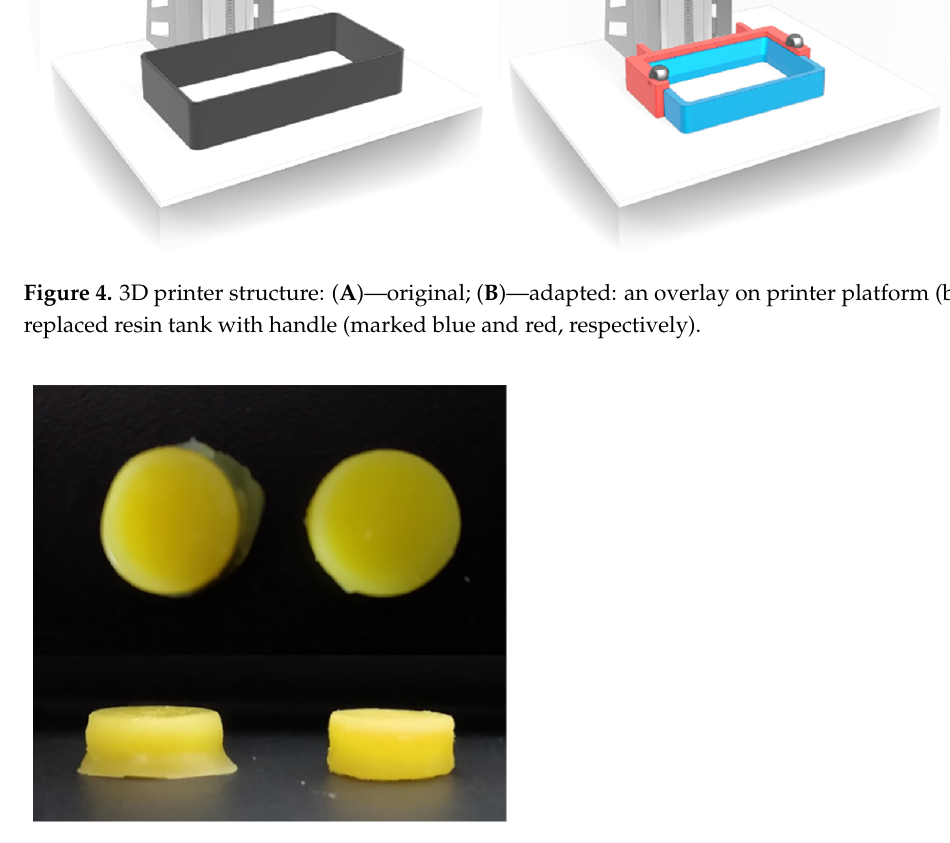
Figure 5. Tablets printed on original ( left side) and modified printer platform ( right side). Despite the modification of the printer, the diameter of TP_100/200 tablets was 8% larger in comparison to the project (Table 6). Additionally, the tablets’ mass was not uniform. Thus, we reduced the height of the layer while maintaining the total exposure time to increase the accuracy of the dimensions of the tablets. Despite the long exposure time for the TP_50/100 series, the tablets’ diameter was smaller than theoretical. The tablets’ mass variations were even higher in comparison to those with the previous settings. Moreover, the reuse of resin used once for printing was impossible. During the attempt to use the uncured resin remaining after printing, only small and irregular points were hardened instead of tablets (Table 6, TP_50/100 and TP_50/100 (cid:48) for printing using fresh and reused resin, respectively). Due to the low reproducibility and necessity of preparing fresh resin for each series of tablets, we assessed the effectiveness of additional compounds to improve the resin’s